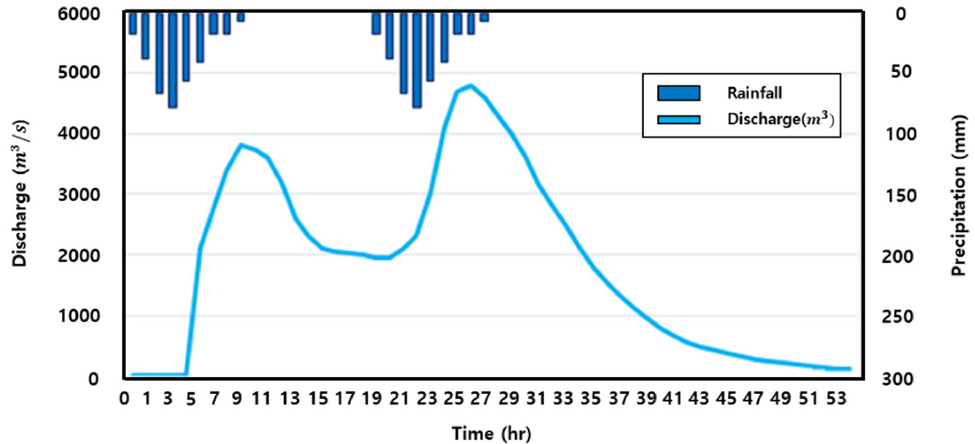
Figure 7. Mega flood runoff discharge simulation using the mega rainfall scenario.